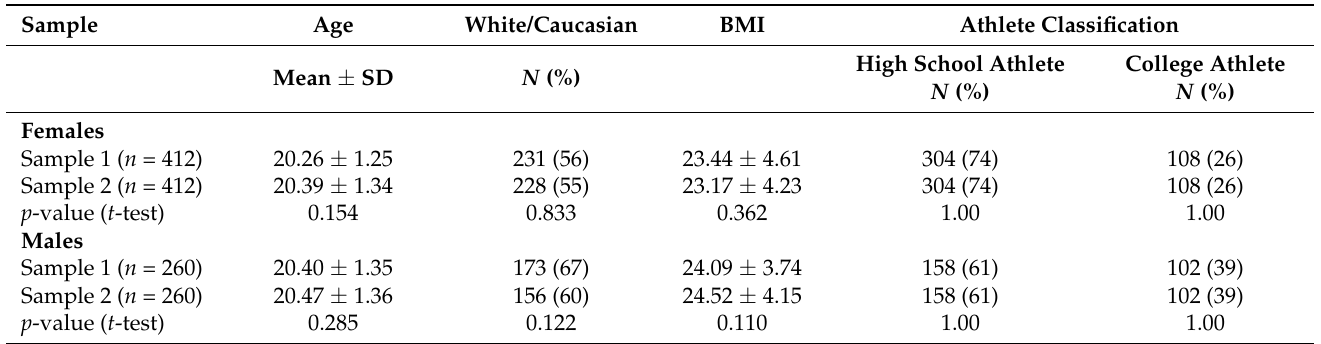
Table 1. Comparison of Characteristics of Female and Male Data Sets 1 and